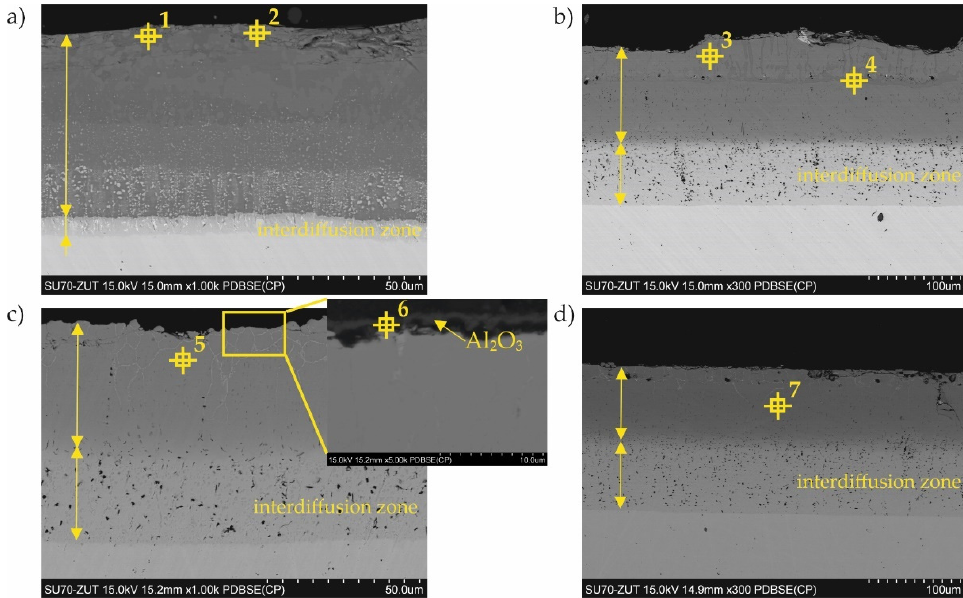
Figure 4. The microstructure (BEI) of the cross-section of Al–Si coatings obtained at ( a ) 800 °C for 2 h (No. 1); ( b ) 1000 °C for 2 h (No. 3); ( c ) 800 °C for 2 h and oxidated at 1000 °C (No. 2); ( d ) 1000 °C for 2 h and oxidated at 1000 °C (No. 4).